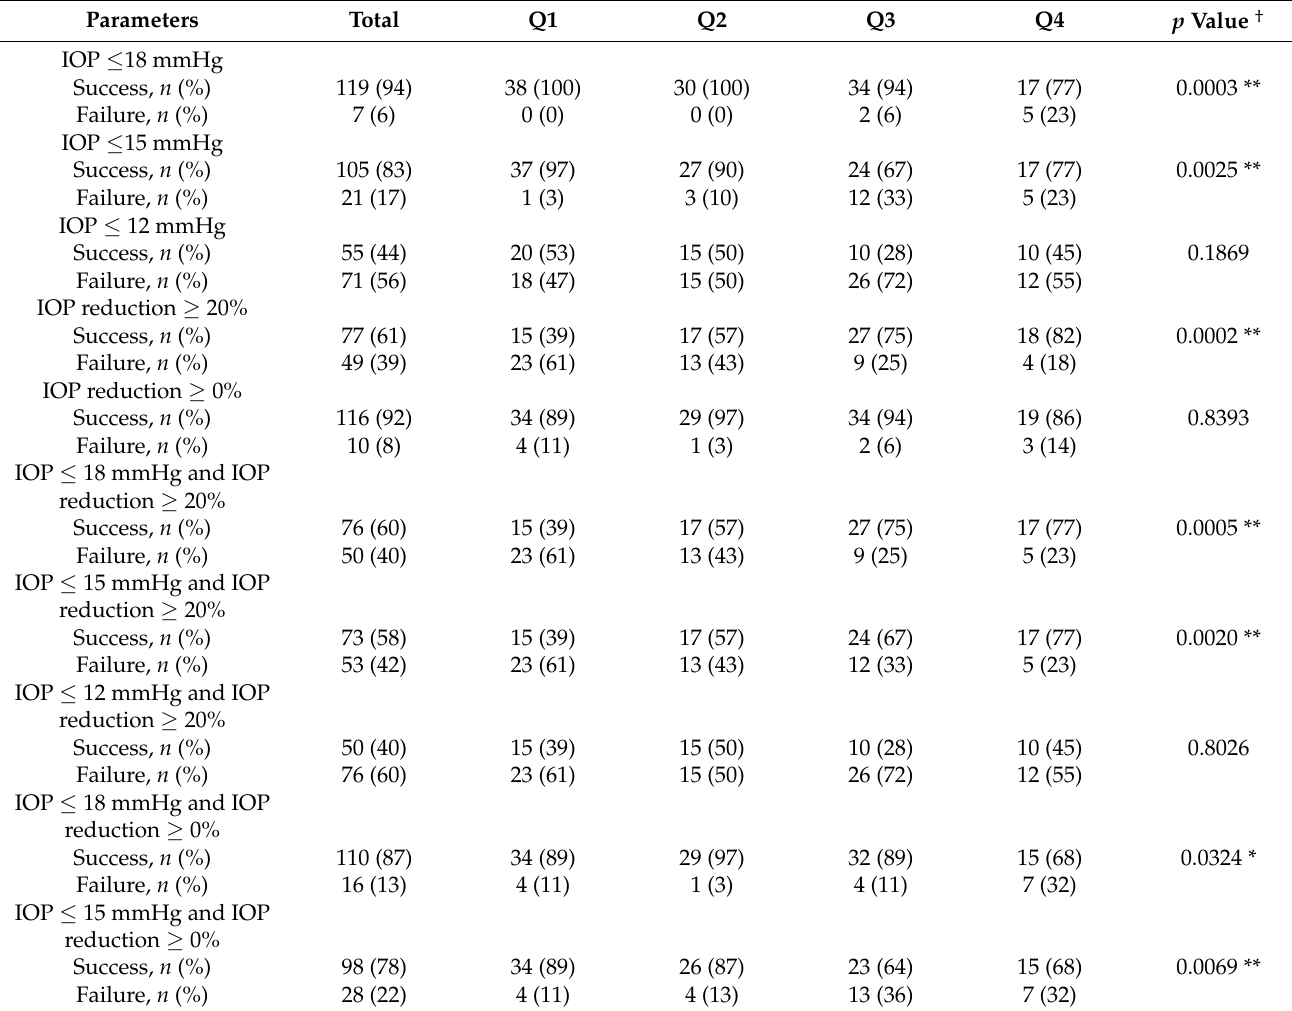
Figure 1. Correlation between preoperative and postoperative 12 months IOP. Blue line and area indicate spline fit ( λ = 14928, R 2 = 0.27, sum of squared errors of prediction = 34915). Table 5. Success rate of IOP control at 12 months